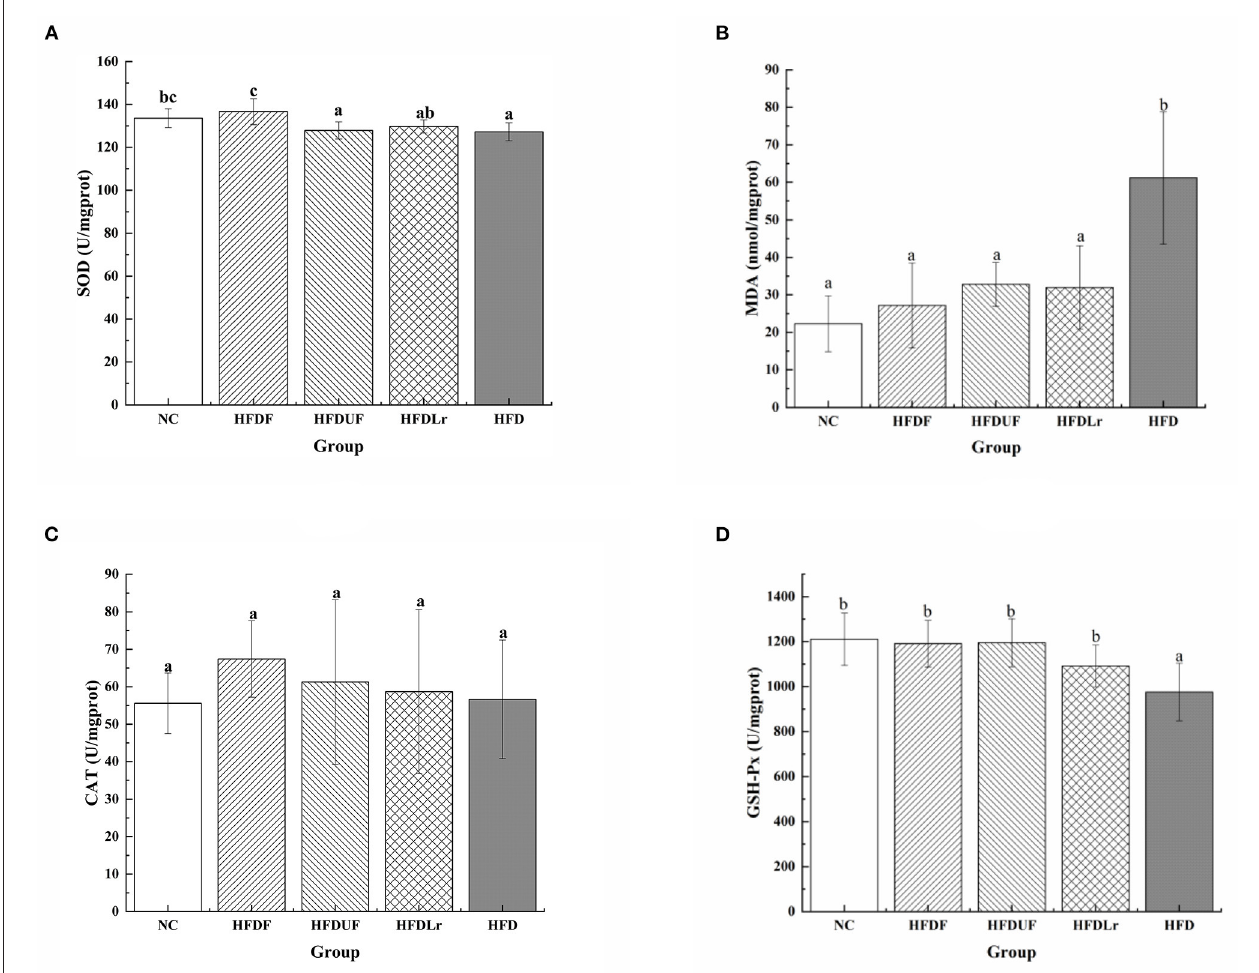
FIGURE 3 | The effects of CSM on the activities of selected antioxidant enzymes in the liver and expression of malondialdehyde (MDA). (A) Superoxide dismutase (SOD), (B) MDA, (C) catalase (CAT), and (D) glutathione peroxidase (GSH-Px). All data are expressed as the mean ± SD ( n = 10 mice/ group). The statistical differences between groups were analyzed using ANOVA. A p value < 0.05 was considered statistically significant. The superscript letters indicate significant differences between